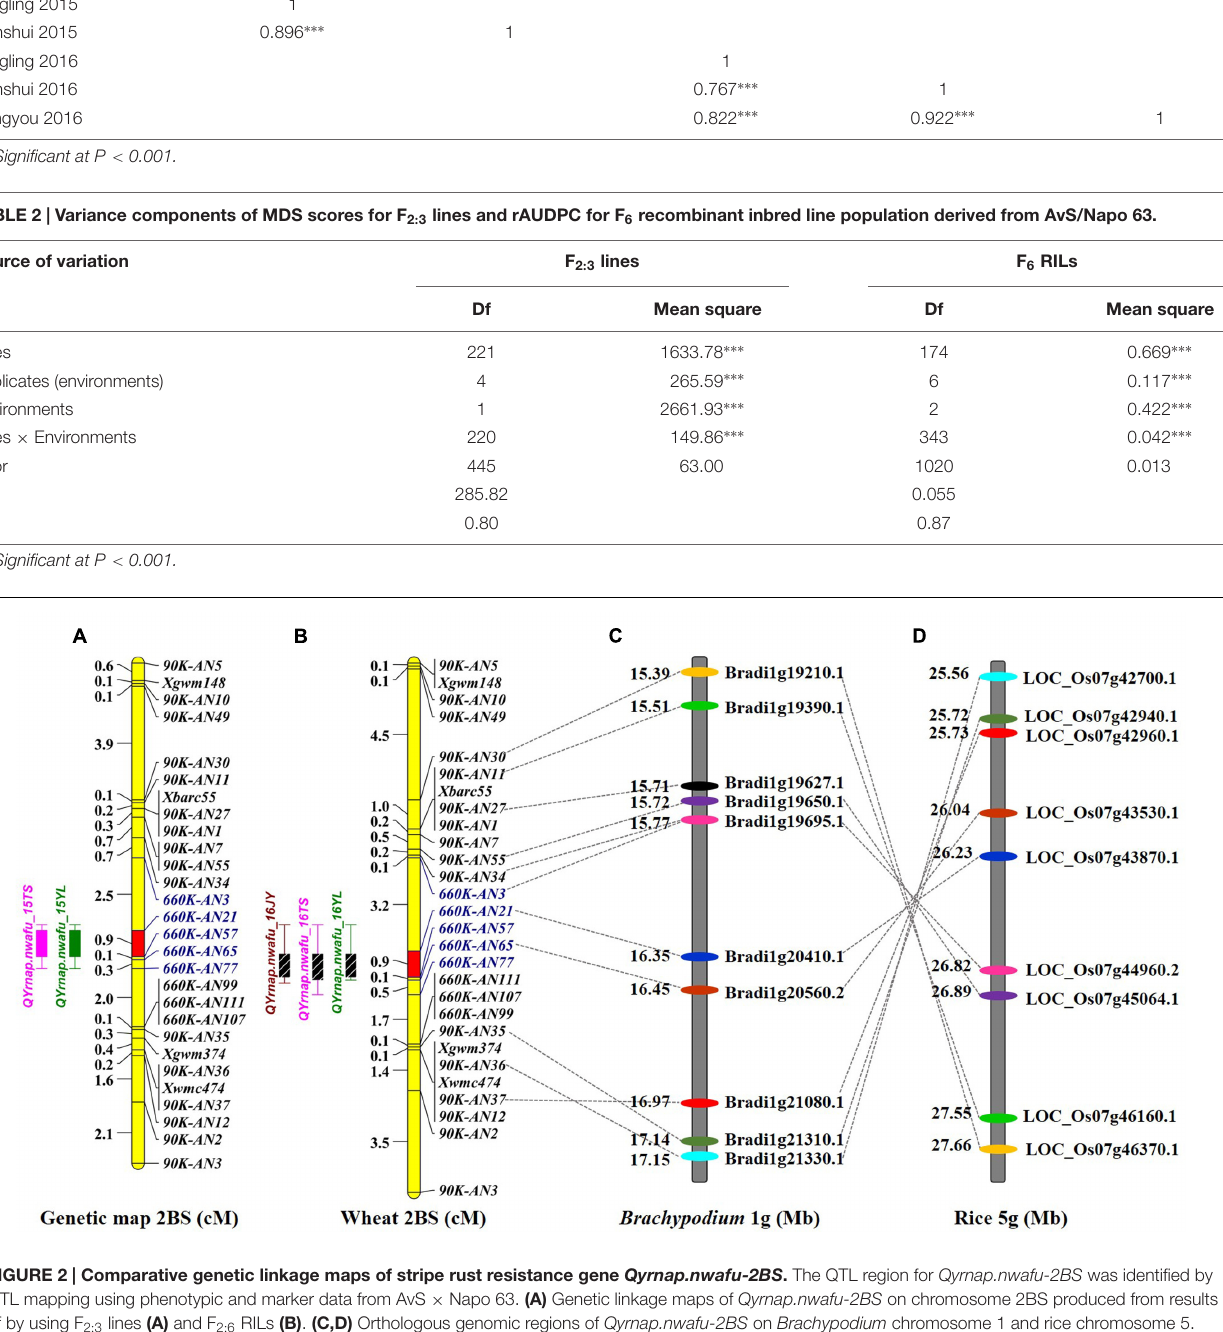
were located on chromosome 2B and the others were